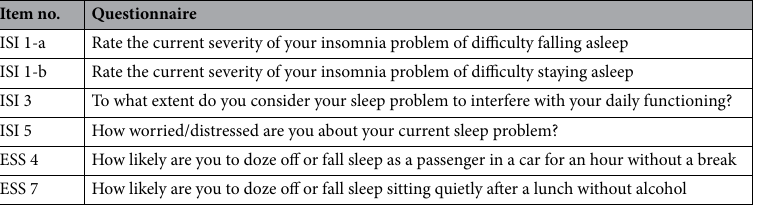
Table 11. Questionnaire list simplified best as 6